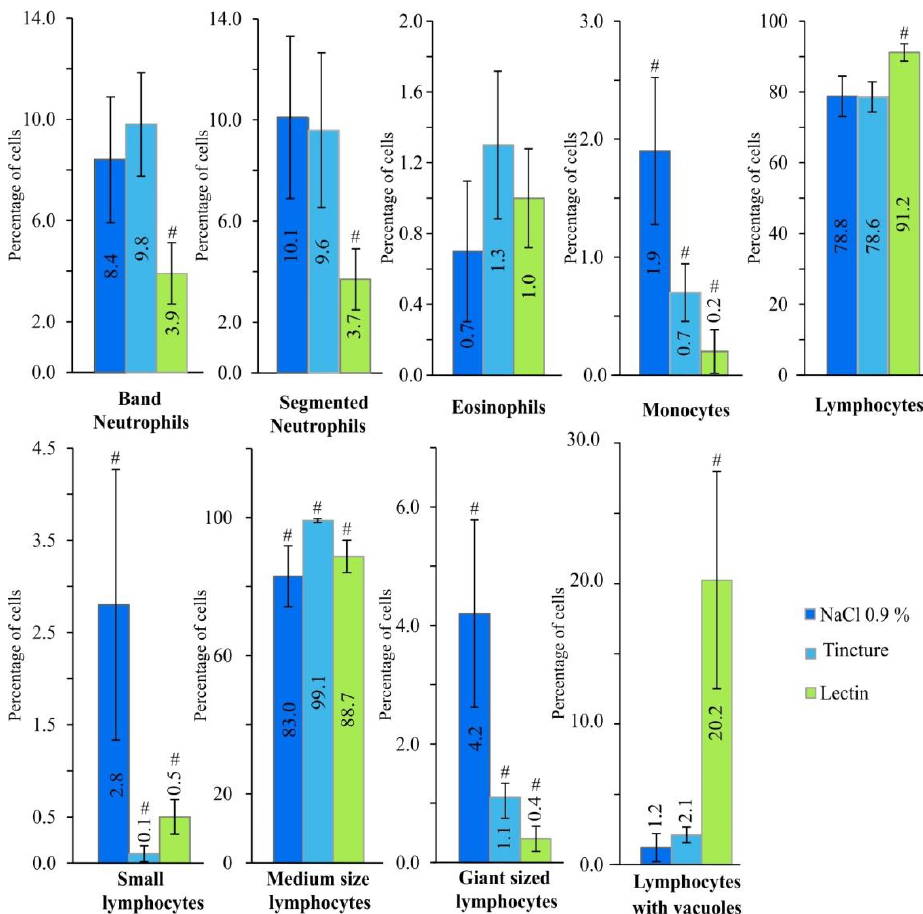
Figure 2. Leukocytes’ formula and white blood cells count comparison after treatment of mice, which was done four times every seven days with NaCl 0.9% 50 μL, EP roots’ tincture 2.5 μL/kg and hemagglutinin’s fraction 2.5 mg/kg. # Statistical significance p < 0.05. The low number of monocytes in the group of the hemagglutinin LysM could indi- cate induced inflammatory processes. Foreign proteins might have induced the mono- cytes’ migration and development to macrophages. In mice, lectin, which was isolated